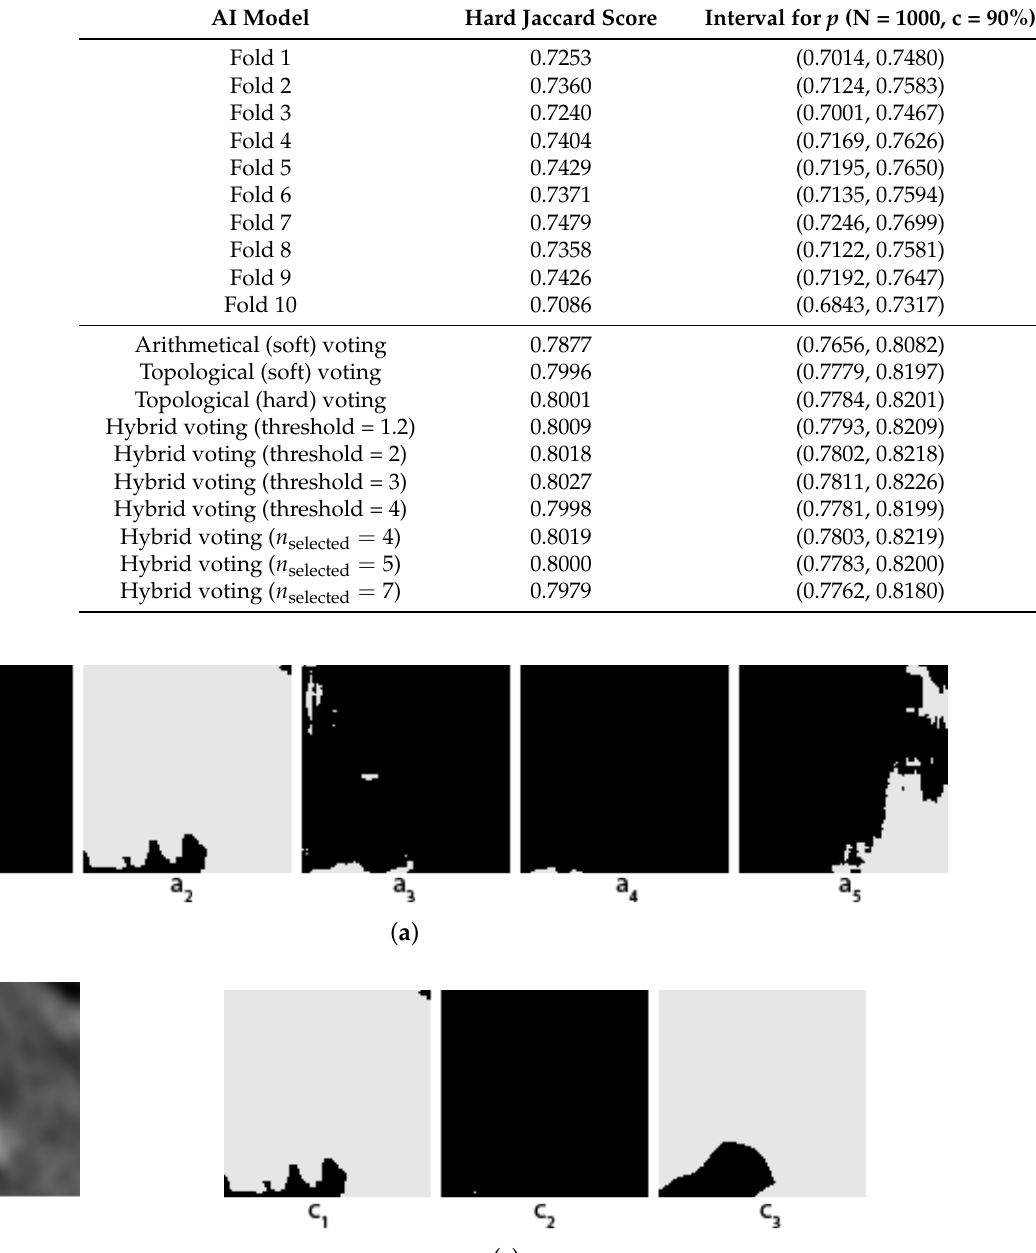
Table 2. Comparison of voting methods on 10 folds for the Salt dataset.